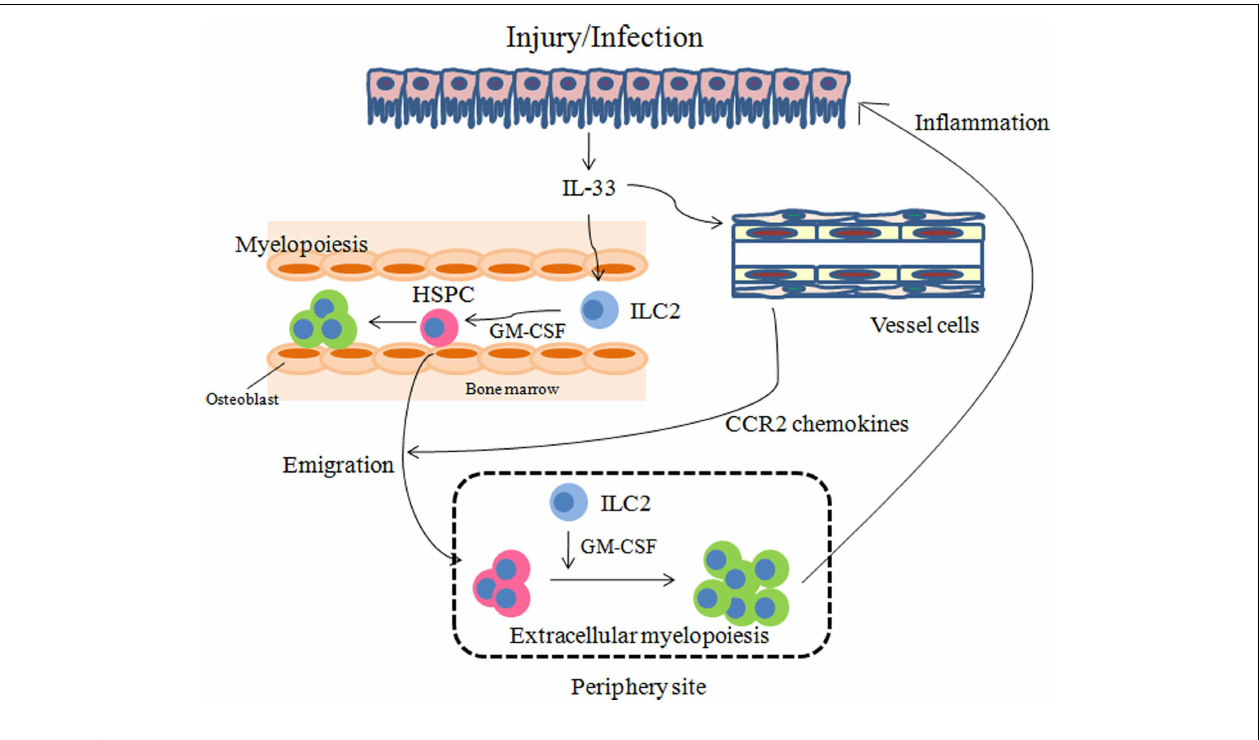
FIGURE 2 | Models for how IL-33 regulates inflammation through HSPCs . IL-33 released by injury or infection may stimulate ILC2s to secrete GM-CSF. On the other hand, vessel cells such as endothelial cells and smooth muscle cells may produce CCR2